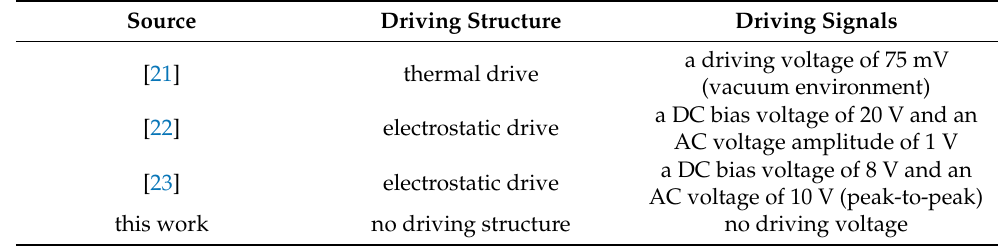
Table 3. The comparison with other microelectromechanic systems (MEMS) voltage sensors.